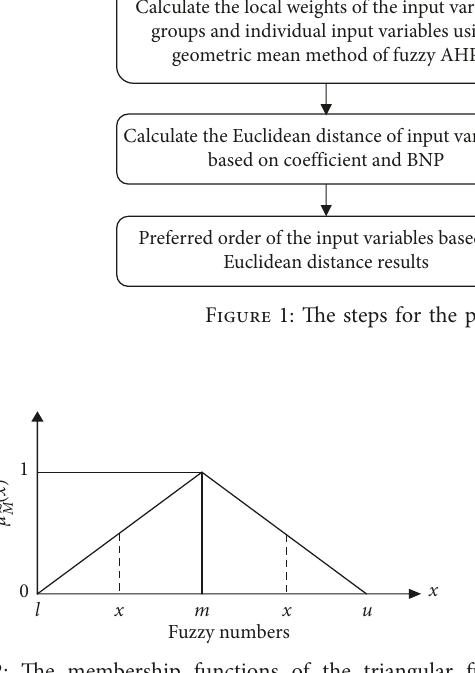
Figure 2: The membership functions of the triangular fuzzy